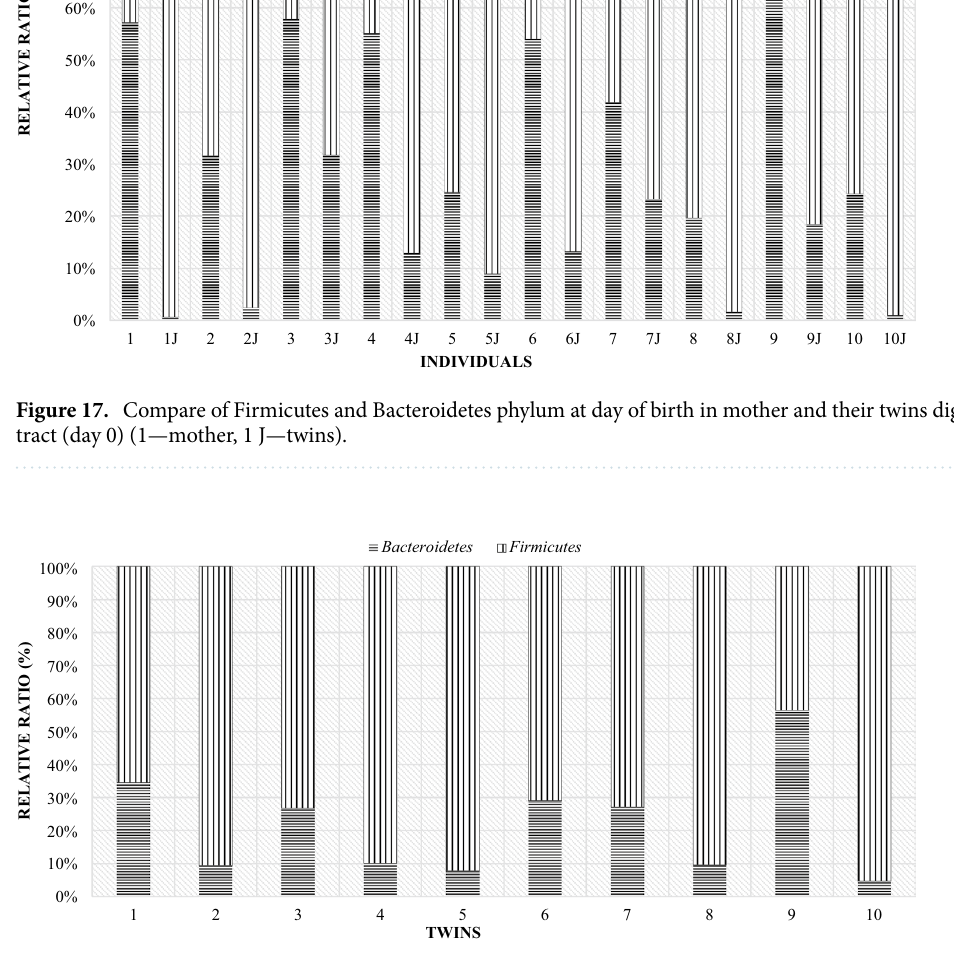
Figure 18. Relative ratio (%) of Firmicutes and Bacteroidetes phylum at 28th day life of